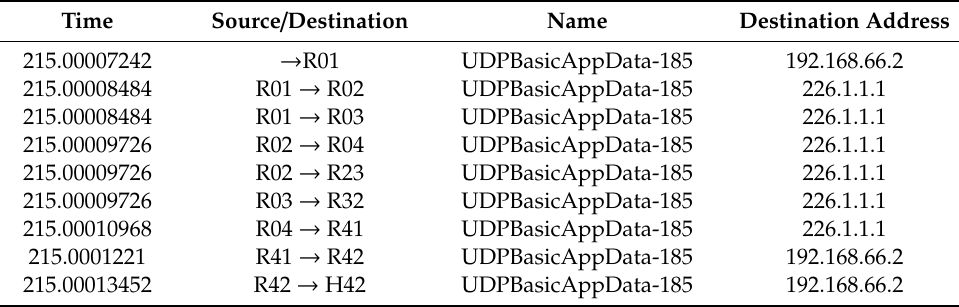
Table 5. The result of the third failure